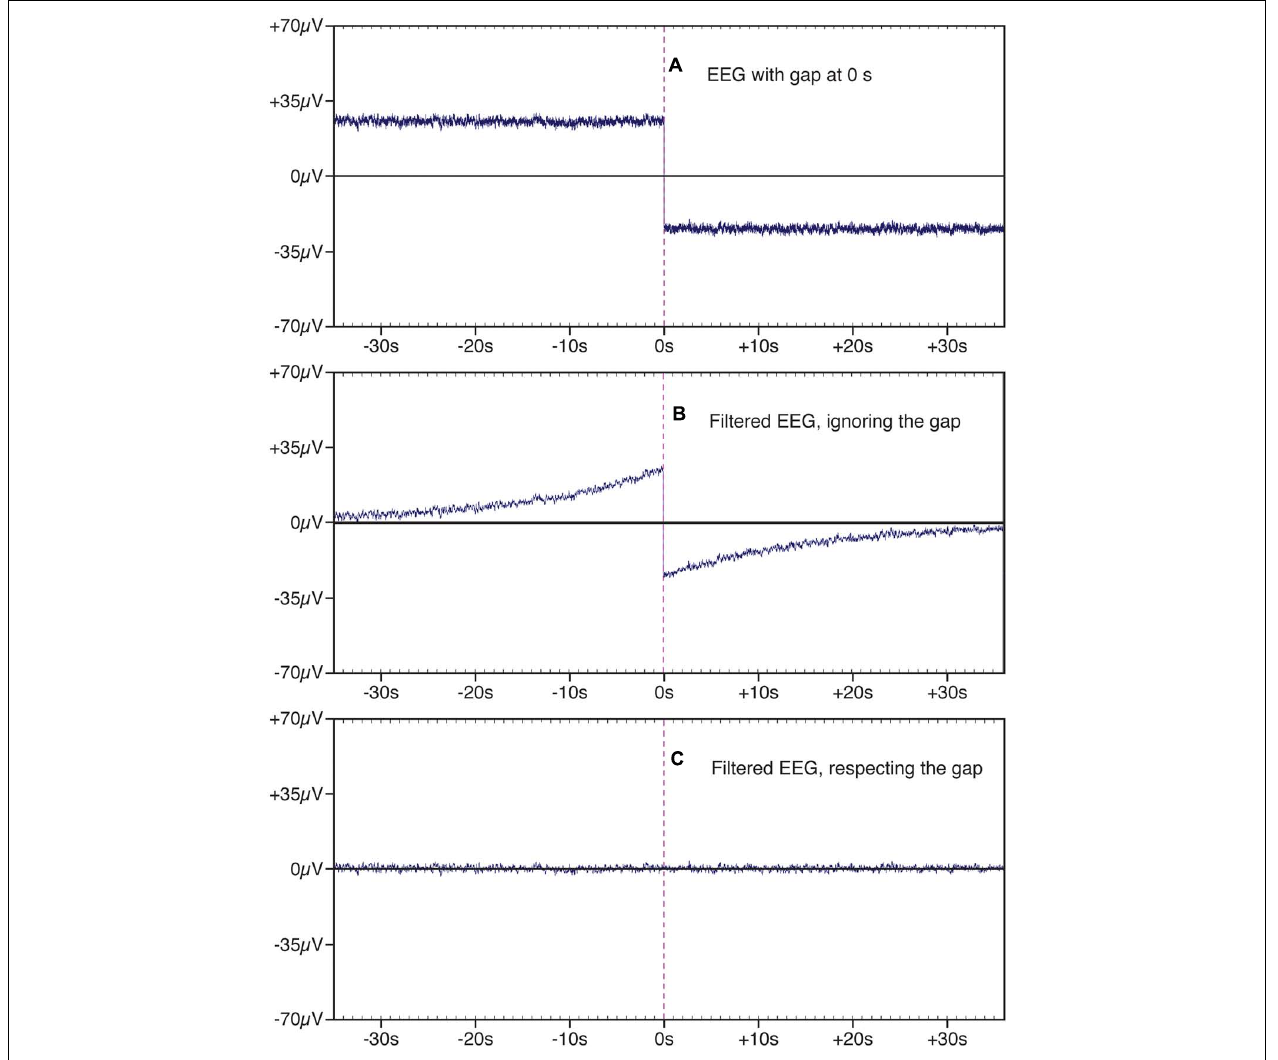
FIGURE 4 | Example of a segment of EEG data in which there is a gap of a few minutes between the end of one trial block and the beginning of another (shown at time zero). This gap leads to the appearance of a large and sudden change in the EEG signal at the transition between blocks (A) . When this signal was filtered with a